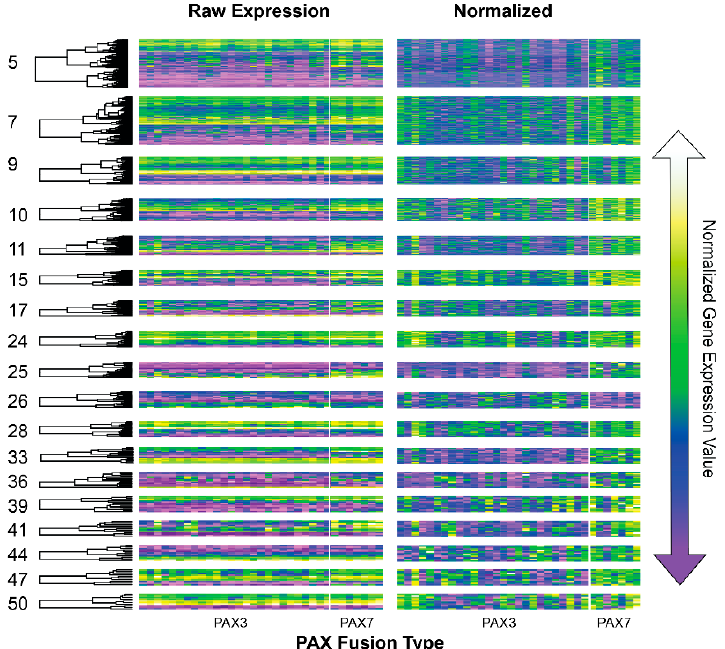
Figure 3. Gene expression heatmaps of co-expression modules that were identified from lmQCM network analysis of FOXO1-PAX3/7 positive samples and that showed differential gene regulation between PAX3 and PAX7 cases. Expression values were organized by hierarchical clustering to better visualize absolute expression values (left). To see potential differences between PAX3 and PAX7 type fusions, gene expression values were normalized (right).